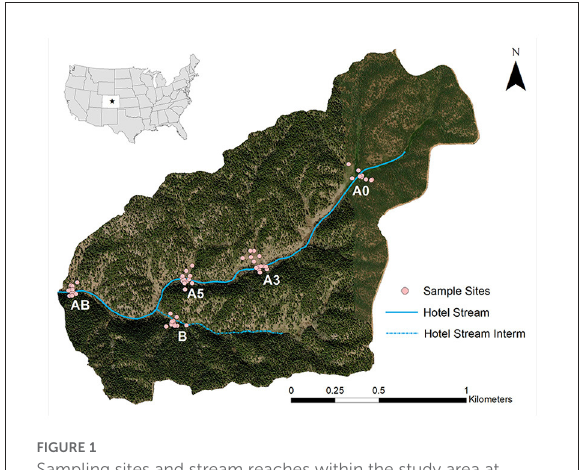
FIGURE1 Sampling sites and stream reaches within the study area at Manitou Experimental Forest. Star on inset map indicates the location of the